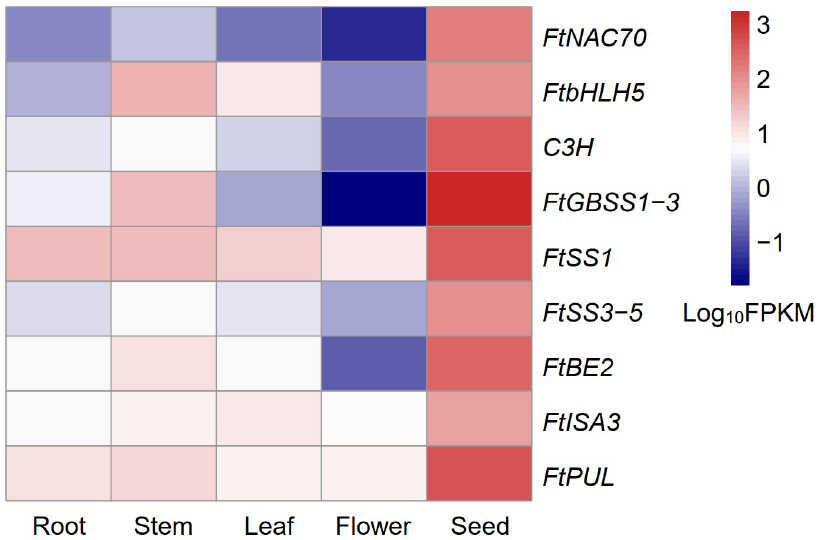
Figure 6. Tissue-specific expression patterns of nine candidate genes in the regulatory network of the starch biosynthesis